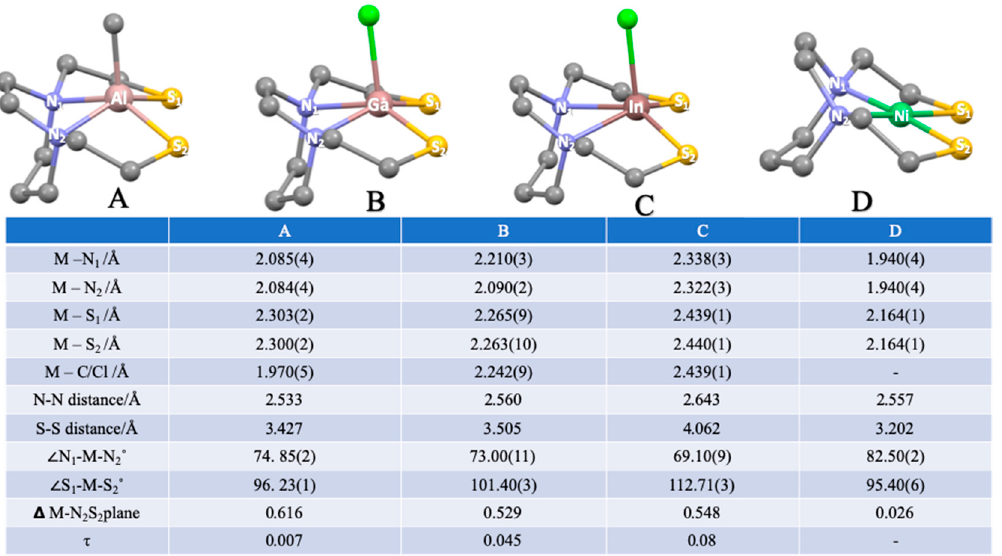
Figure 4. Molecular structures of XMN 2 S 2 complexes from XRD analysis with selected metric data.